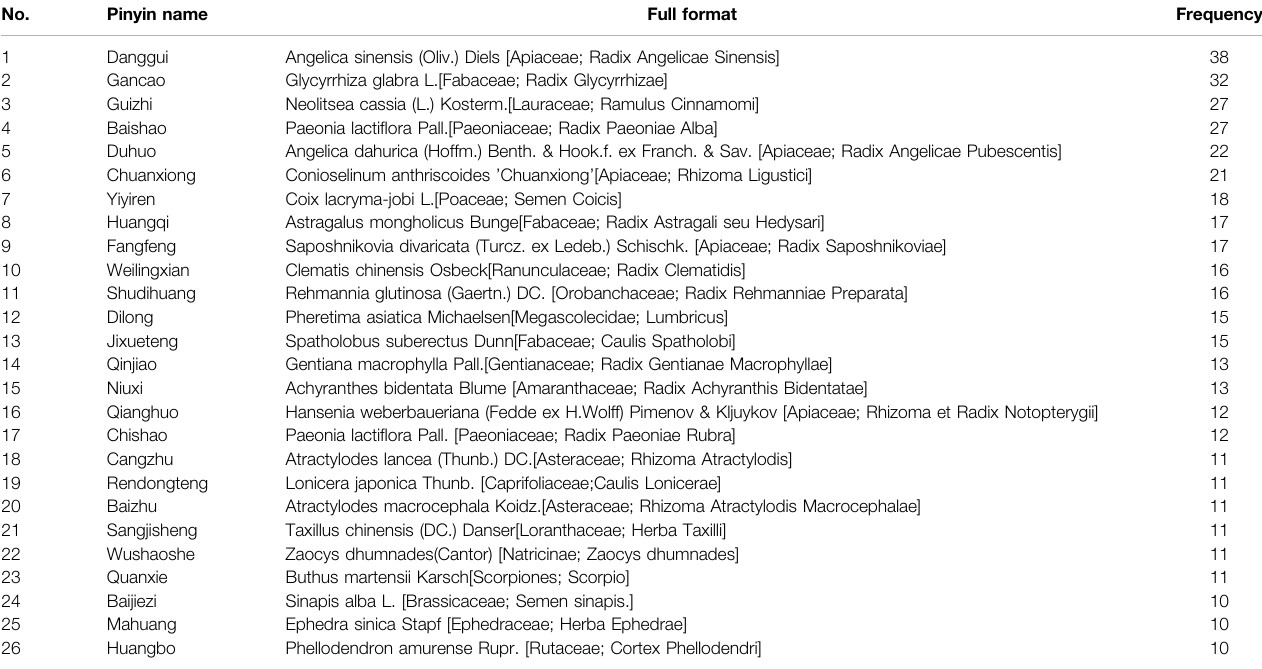
TABLE 4 | The frequency of Chinese medicine (more than 10 times of traditional Chinese medicine).